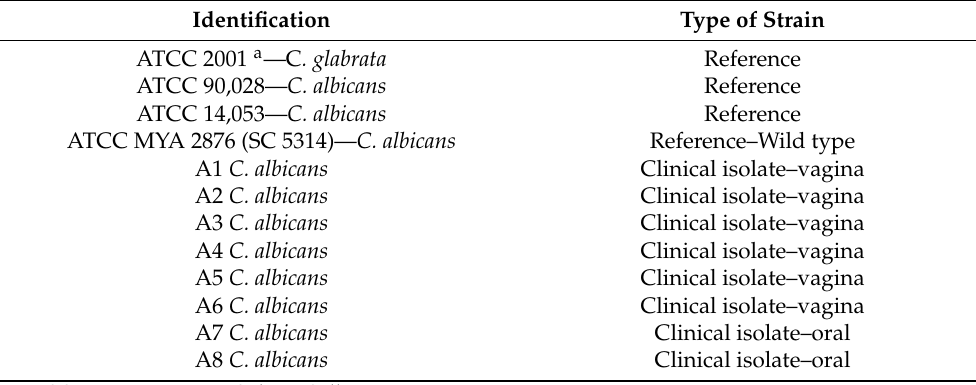
Table 6. Reference strains